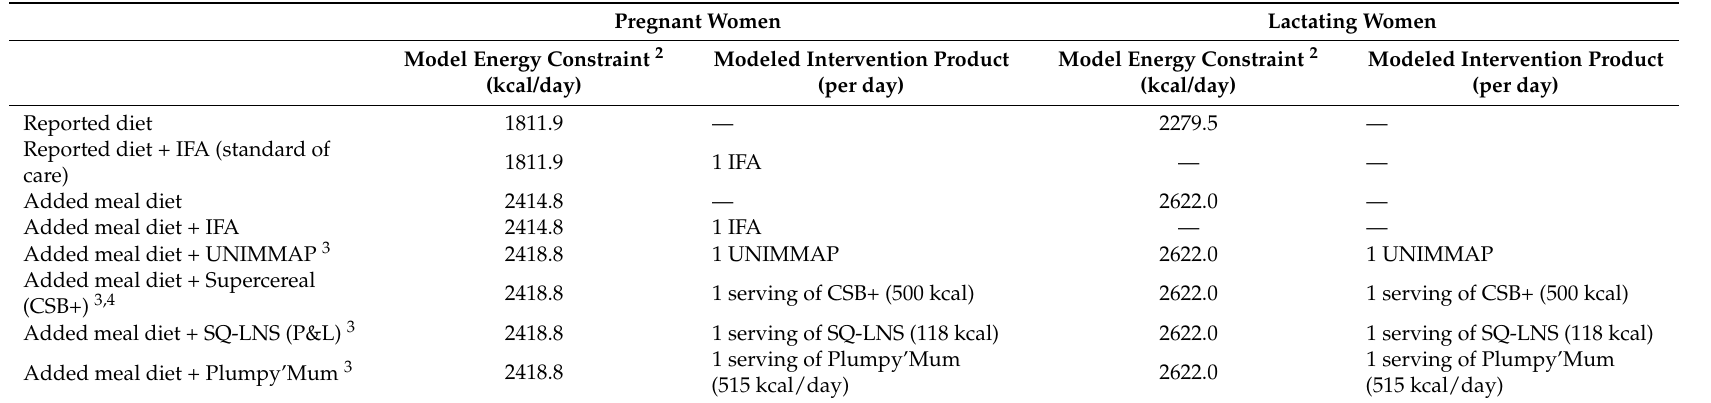
Table 1. Series of linear programming models developed, with alternative intervention products, using the Optifood software tool 1